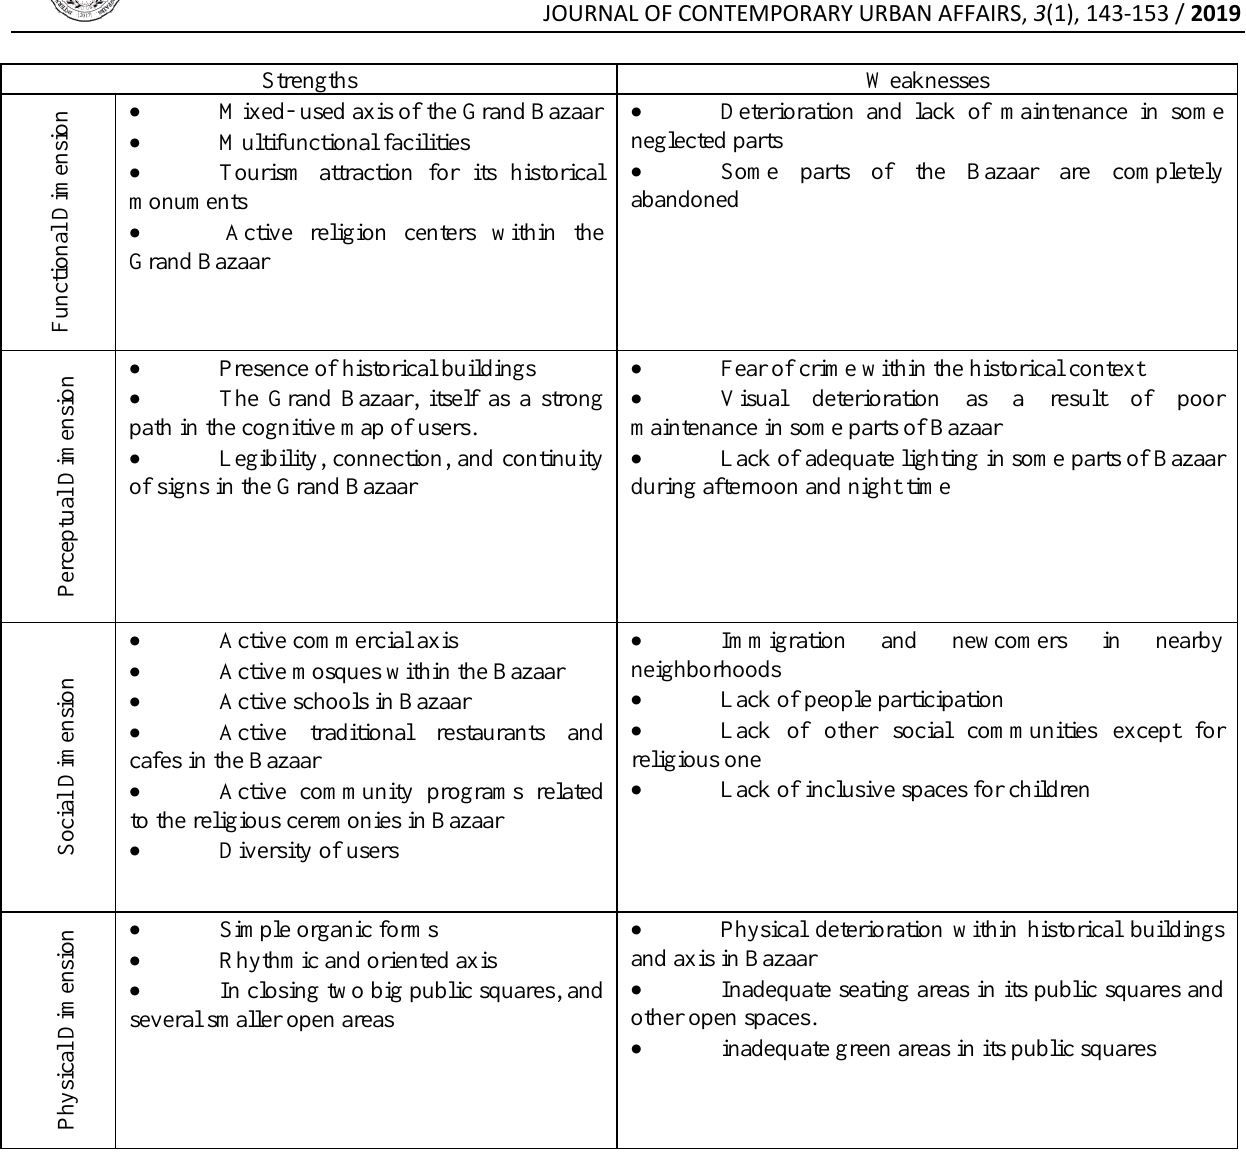
Table 1. Strengths and weaknesses of functional, perceptual, Social, and physical